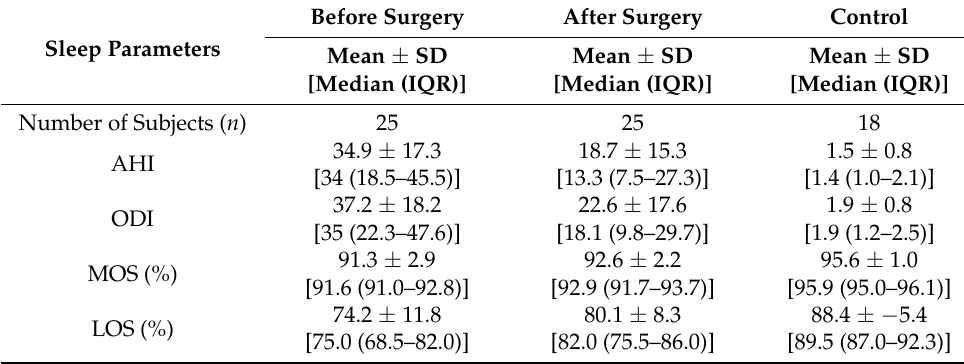
Table 1. Results as mean values and standard deviation (SD) and median values with interquartile range (IQR) of the apnea–hypopnea index (AHI), oxygen saturation index (ODI), mean oxygen saturation (MOS), and lowest oxygen saturation (LOS) in the pre-operative group, post-operative group, and control group. Before Surgery After Sleep Parameters